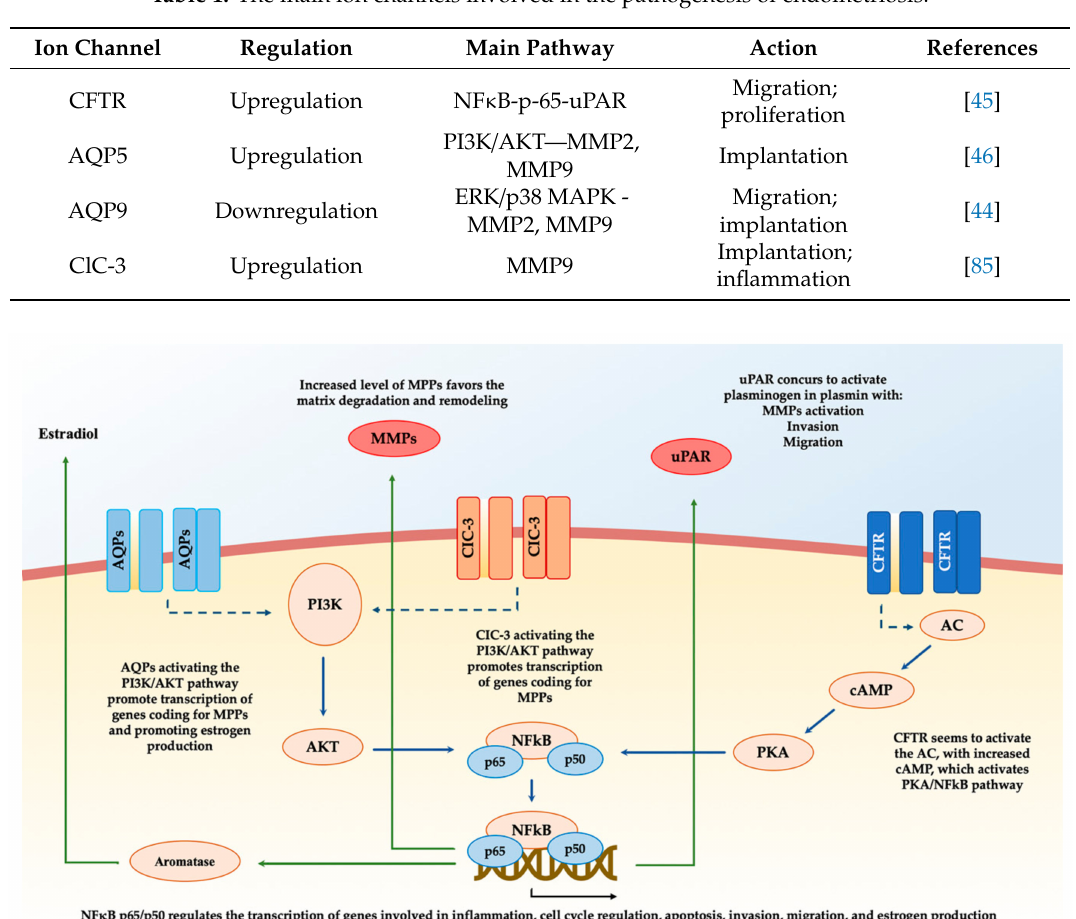
Table 1. The main ion channels involved in the pathogenesis of endometriosis.